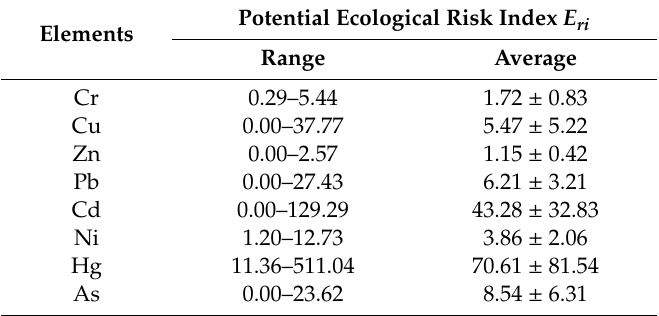
Table 11. Values of the potential ecological risk index ( E ri